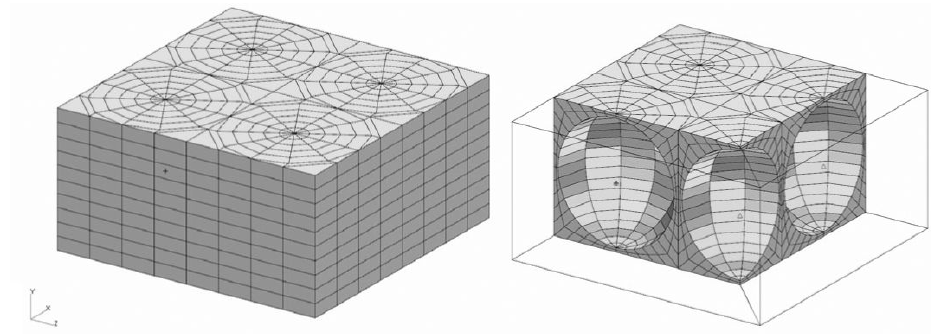
Fig. 14. Quadruple Cell 3D dynamic